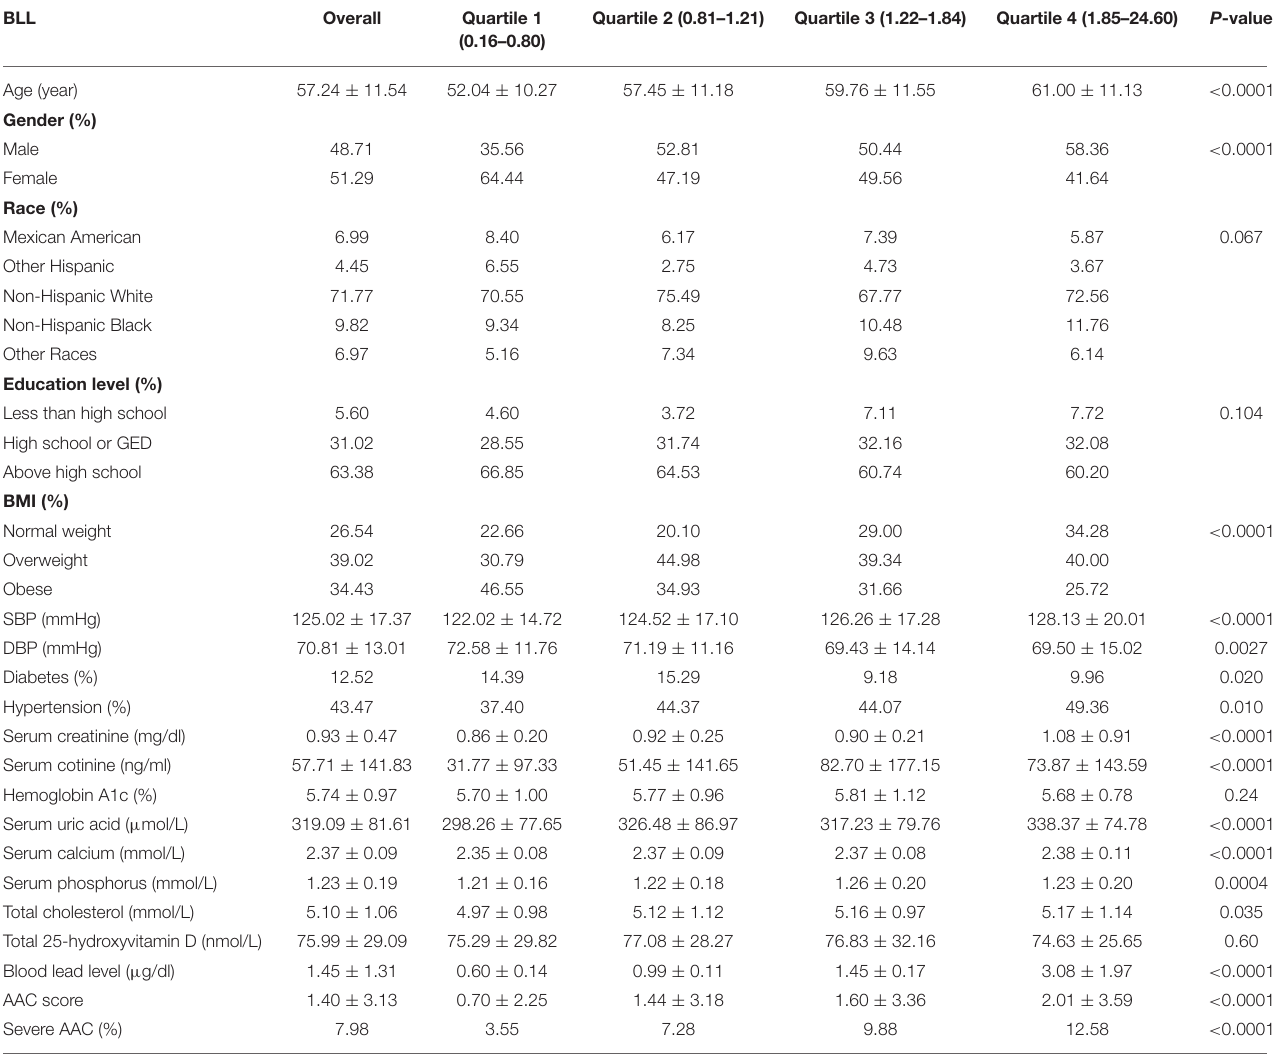
TABLE 1 | Baseline characteristics of participants,